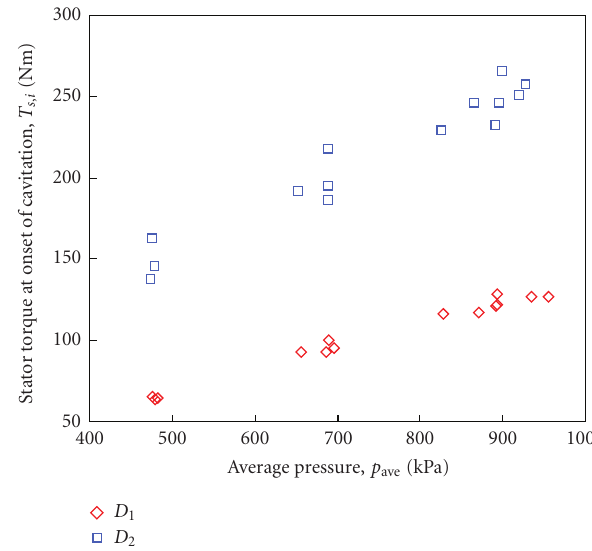
Figure 6: Stator torque at the onset of cavitation threshold versus average absolute pressure superimposed upon the torque converter.